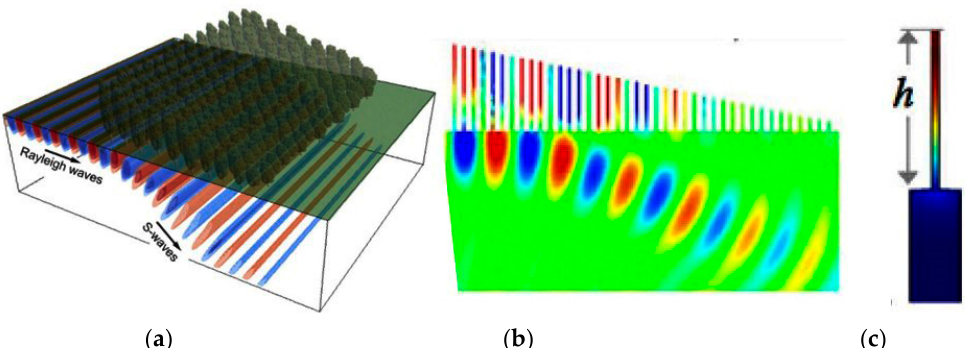
Figure 7. The conversion phenomenon of NMs as rendered from the 2D numerical simulations: ( a ) artist view; ( b ) displacement plot; ( c ) unit cell. Figure reproduced from [215].